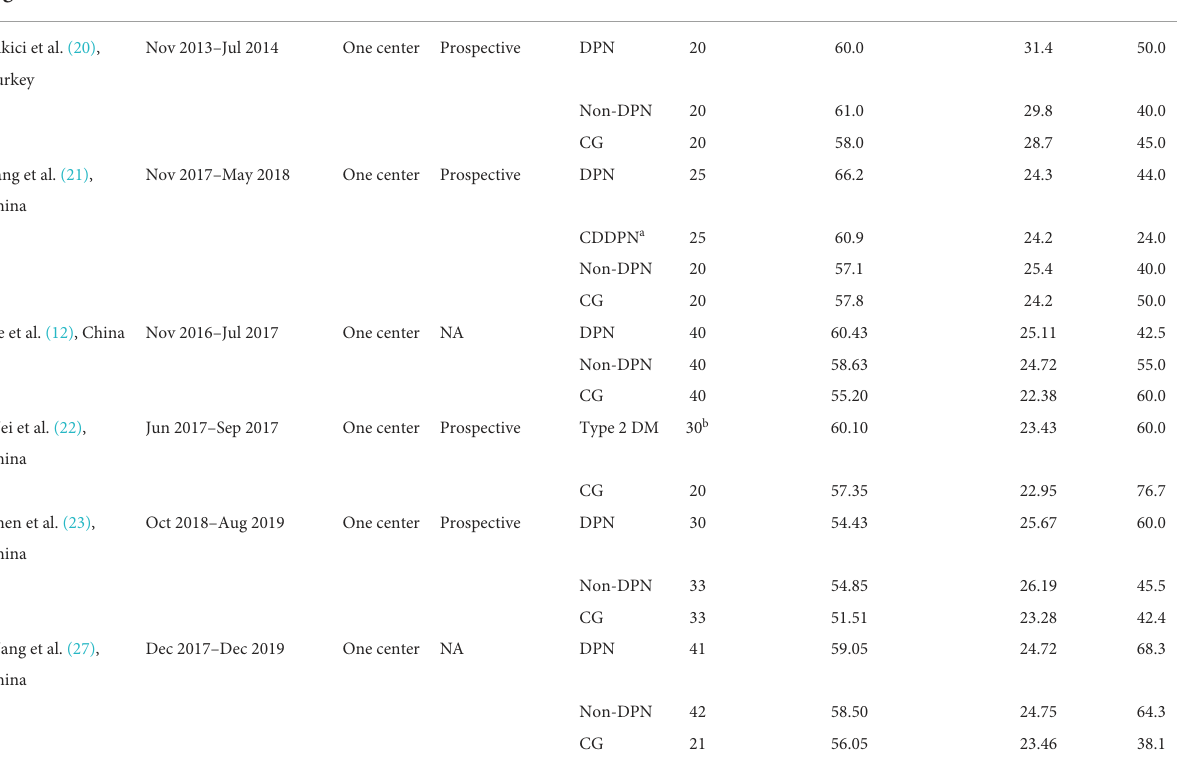
TABLE 1 Basic characteristics of the included